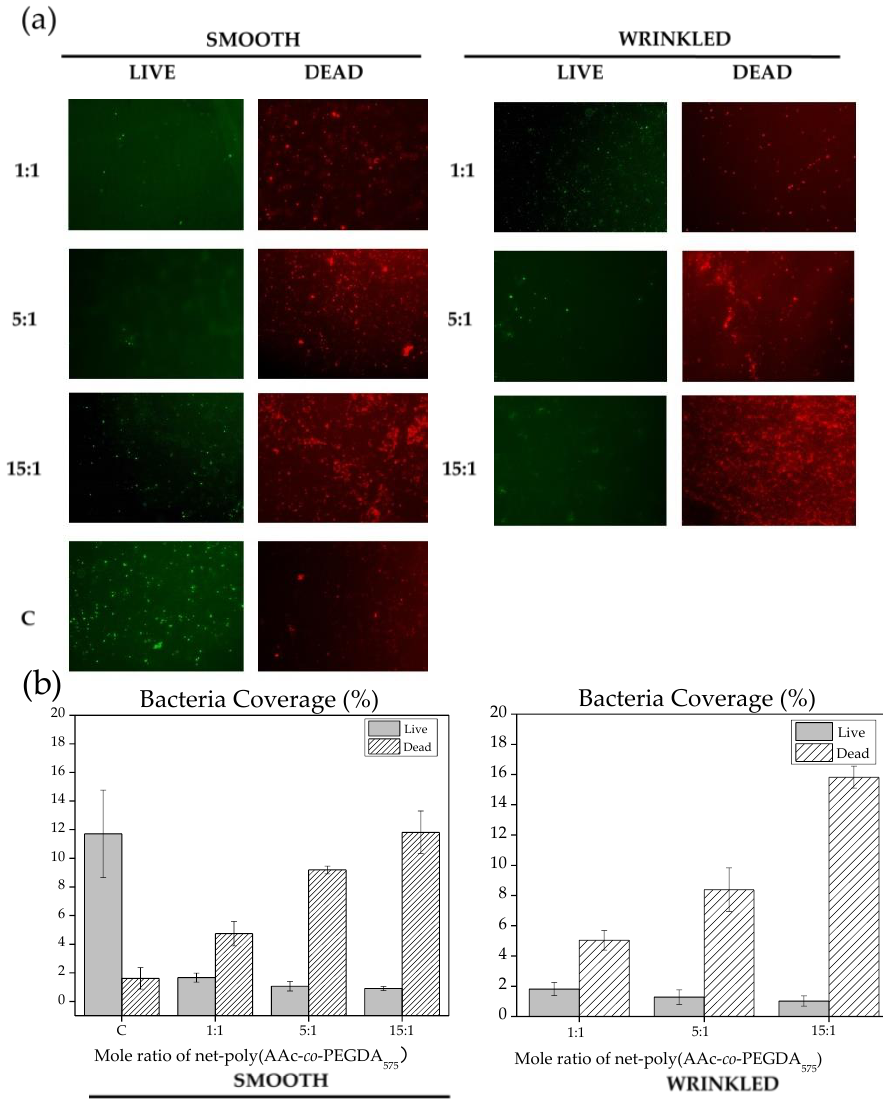
Figure 11. LIVE/DEAD assay for smooth and wrinkled AAc films incubated with Escherichia coli bacteria strain: ( a ) live (green) and dead (red) bacteria over wrinkled, smooth, and control (C) films after 48 h of incubation and ( b ) surface area coverage (%) of bacteria culture after ImageJ analysis.